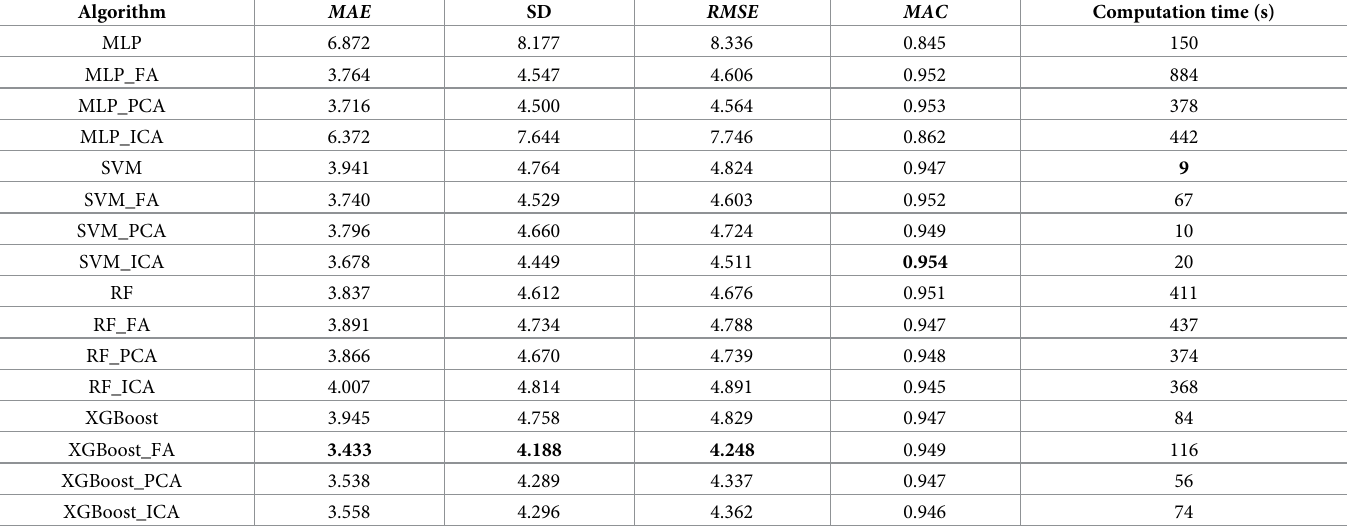
Table 3. Experimental results based on the StatLib dataset (best results are highlighted in